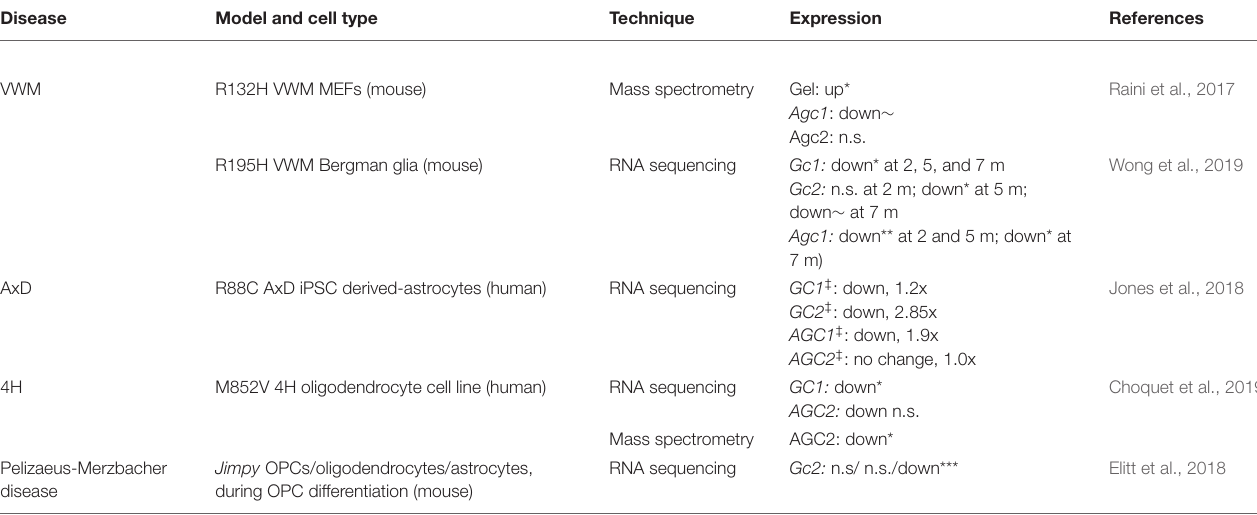
TABLE 1 | Overview of findings of altered (A)GC expression in leukodystrophies.